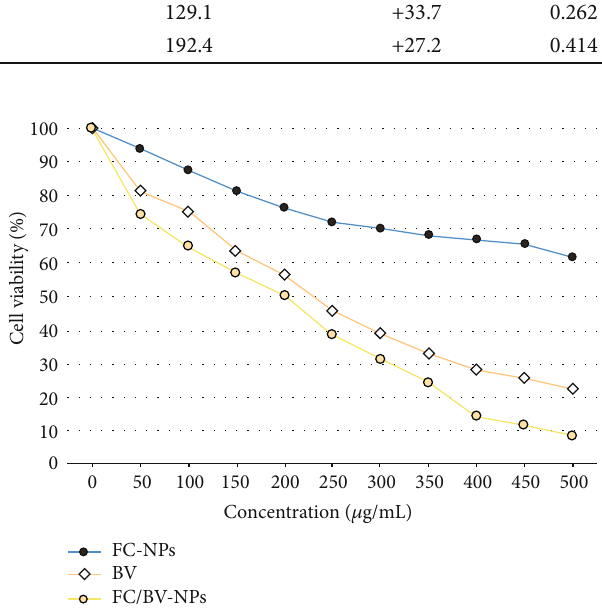
Figure 4: Cancer cell (HeLa) viability after exposure to nanofungal chitosan (FC-NPs), bee venom (BV), and their nanocomposite (FC/BV-NPs) for 24h using di ff erent concentrations from each of